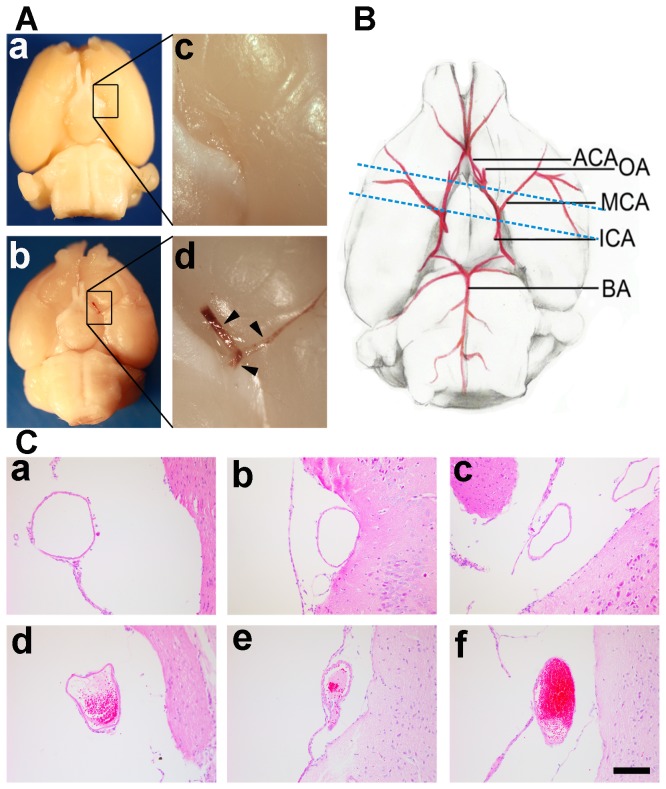
Thrombosis in vascular after reperfusion detected by HE-staining.(A) Stereomicroscopic imaging of brain was performed after 1 to 3 hours after reperfusion. No blood clotting was detected in the Circus Willis in successfully reperfused mice (a, c) while blood clotting was clearly detected in MCA, ACA and ICA territory in heparin-free mice with failed reperfusion (b, d). Arrowheads indicate thrombus in the MCA, ACA and ICA. (B) Schematic diagram of paraffin section indicating the location of ACA, MCA and ICA. (C) HE-staining shows the cross-sections of ICA (a), MCA (b) and ACA (c) in successfully reperfused mice with no thrombus in the lumen after reperfusion. In contrast, the cross-sections of ICA (d), MCA (e) and ACA (f) in mice with failed reperfusion have mixed thrombus in the lumen after suture withdrawal. Bar= 100 µm. ACA: anterior cerebral artery, ICA: internal carotid artery, MCA: middle cerebral artery.